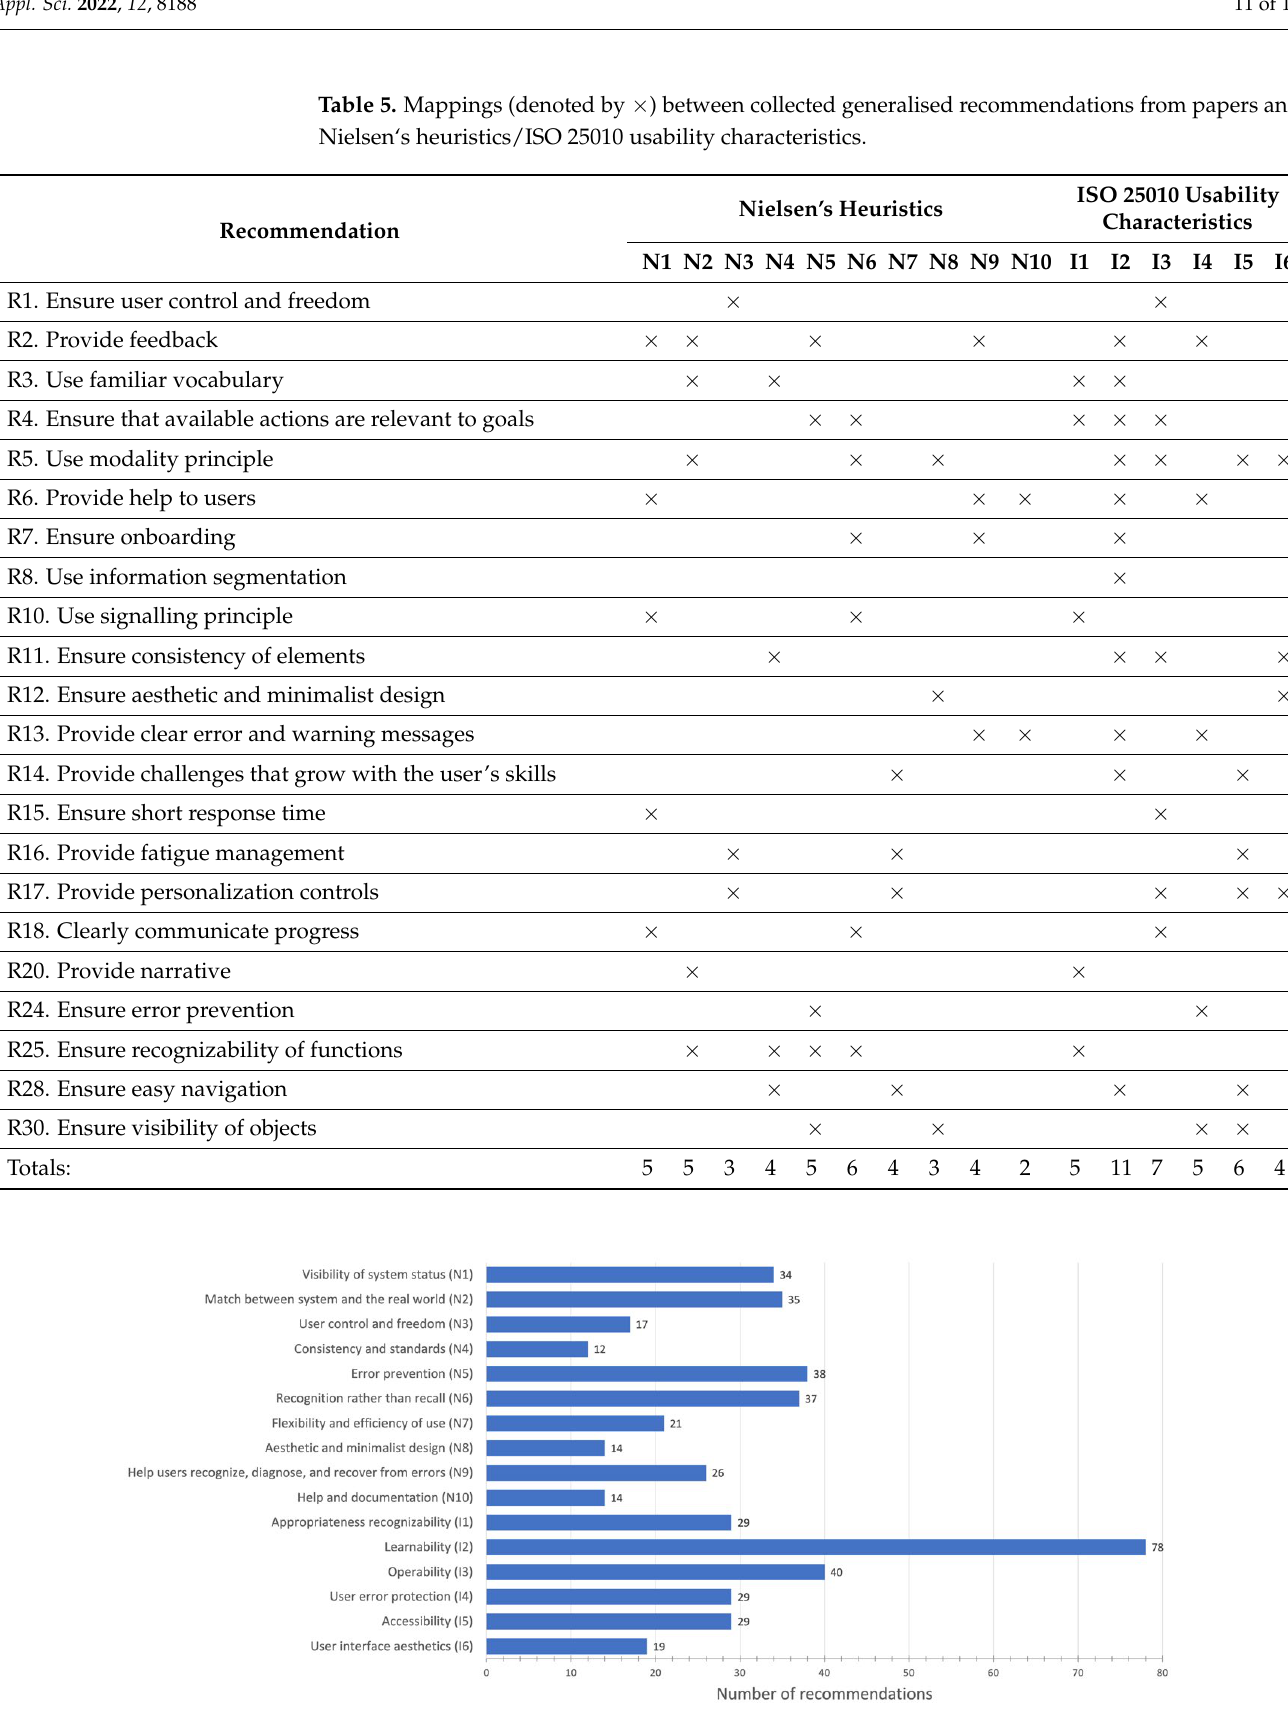
Figure 5. Number of recommendations—prior to merging similar ones—in each of the groups (Nielsen’s heuristics and ISO 25010 usability